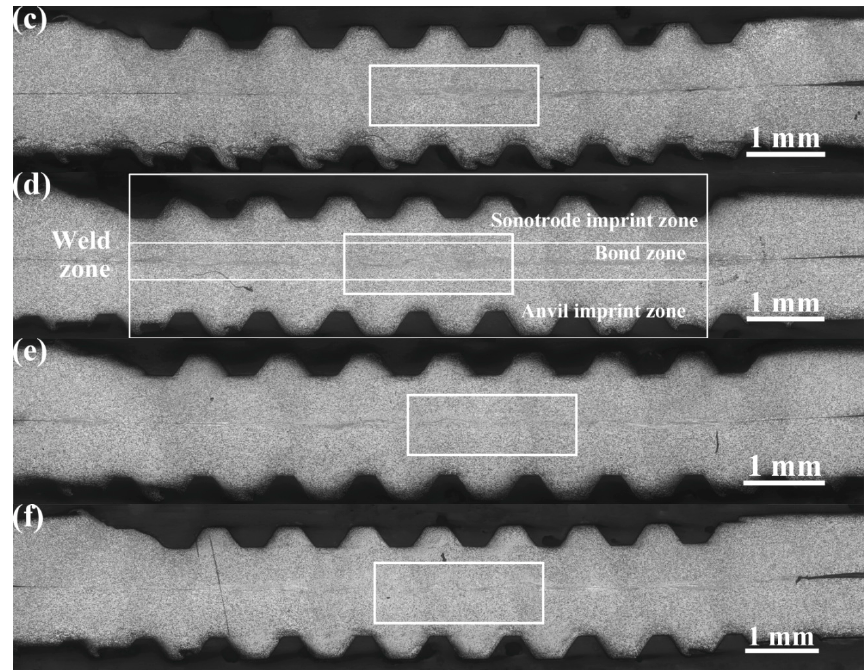
Figure 2. Typical micrographs for macrostructure of cross-sections of USW joints produced from welding energy increase: ( a ) 400 J; ( b ) 800 J; ( c ) 1200 J; ( d ) 1600 J; ( e ) 2000 J and ( f ) 2400 J .